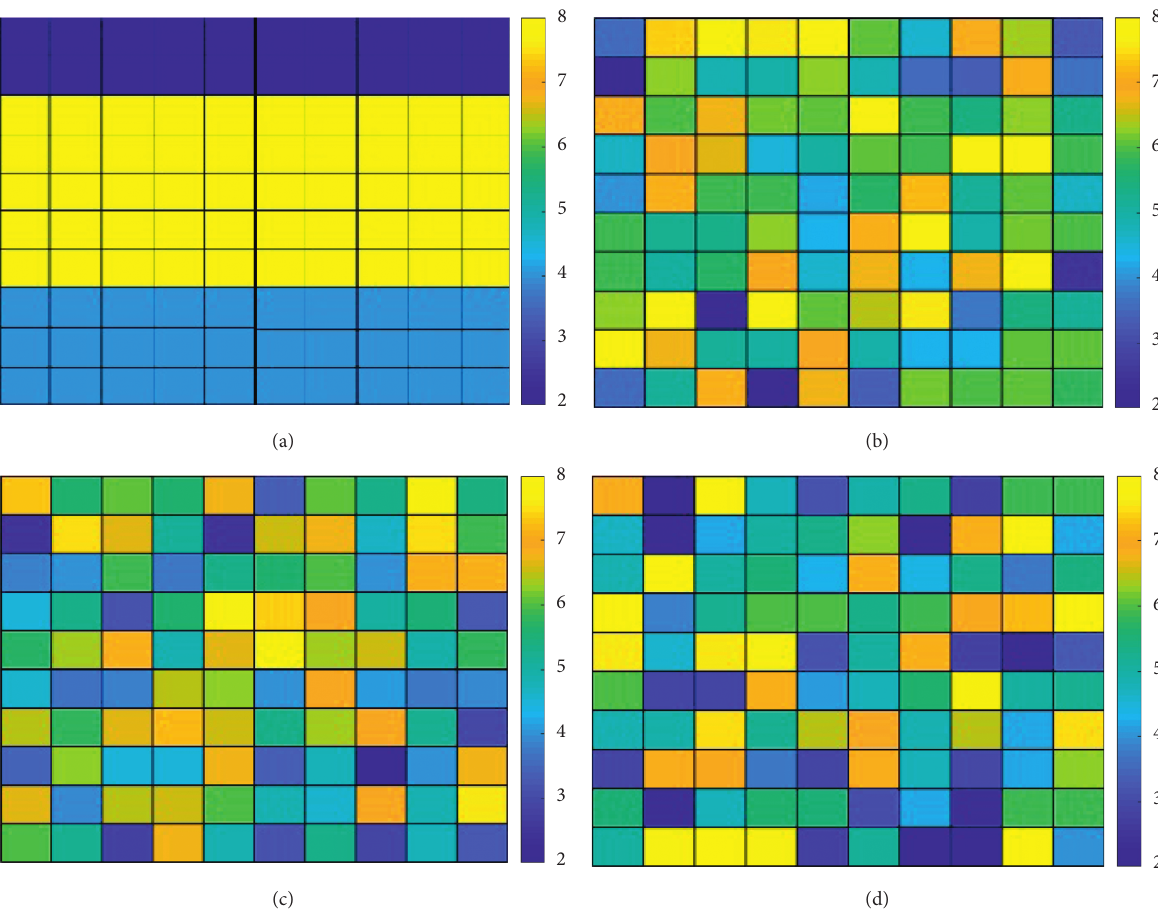
Figure 9: Reconstruction result of different algorithms. (a) Proposed algorithm. (b) PSO. (c) DE. (d)